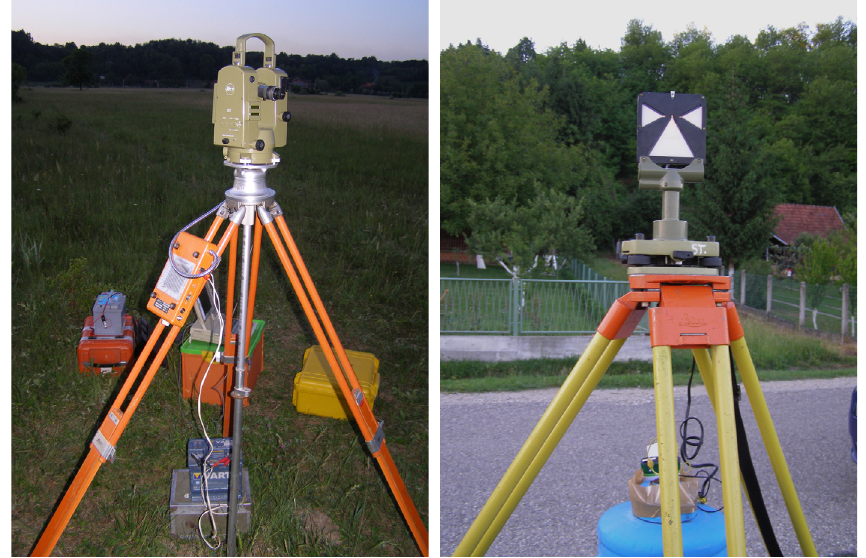
Figure 5. Automated measurement system (Kern E2 + notebook computer) (left). Illuminated signal on the reference mark for the observation in the darkness